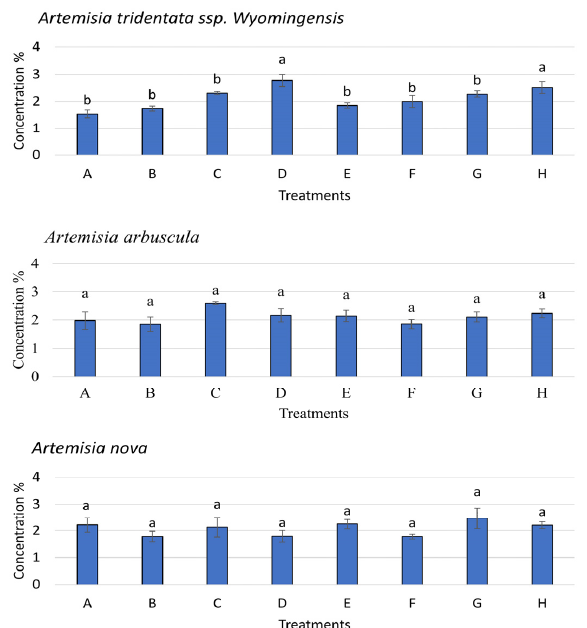
Figure 7. Potassium (K) concentration ± SE (error bars) in Artemisia tridentata ssp. wyomingensis , Artemisia arbuscula , and Artemisia nova . Different letters above bars indicate significant differences among treatments (Tukey’s HSD). K content of Artemisia species grown under competition not measured.